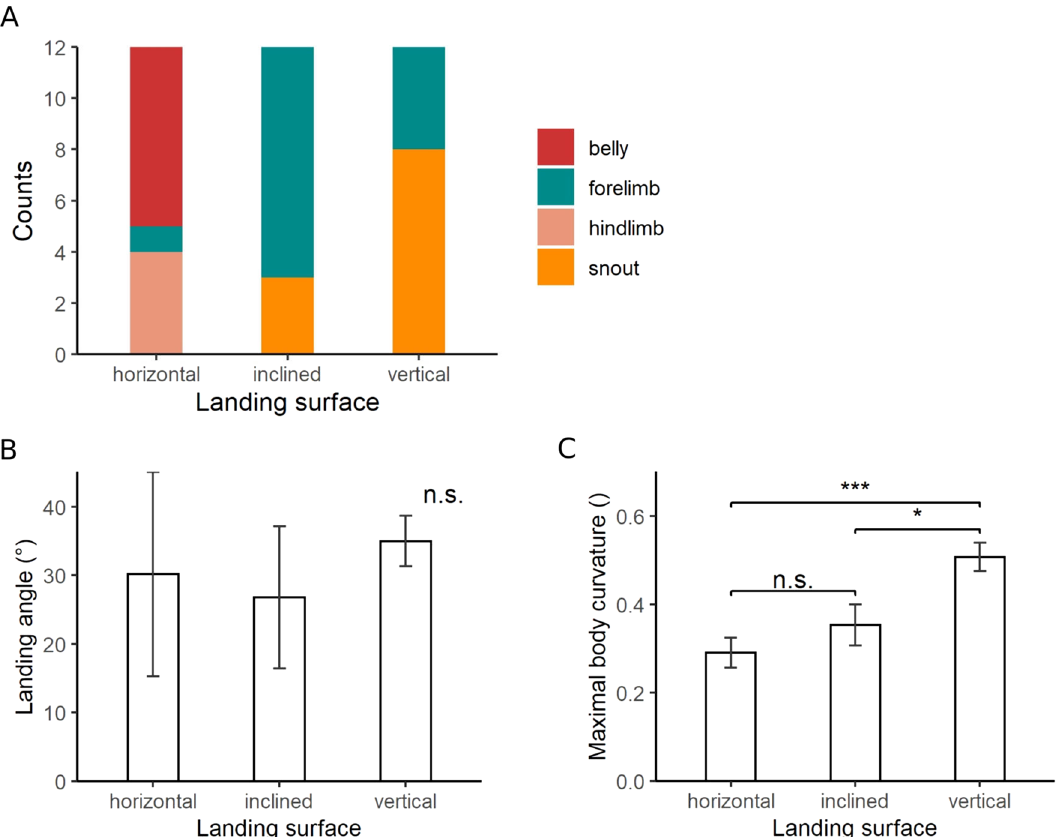
Figure 7. Body posture during landing. ( A ) Summary of which body part touched the landing platform first. ( B ) Landing angle, as measured in Fig. 2A, which is between the line intersecting the snout and eye line and the horizontal plane. ( C ) Maximum body curvature during landing, measured as the ratio of body deflection and the distance between snout and basis of the tail. Bar plots show mean values and standard errors. n.s.: no significance; *: 0.01 < p < 0.05; ***: p < 0.001.